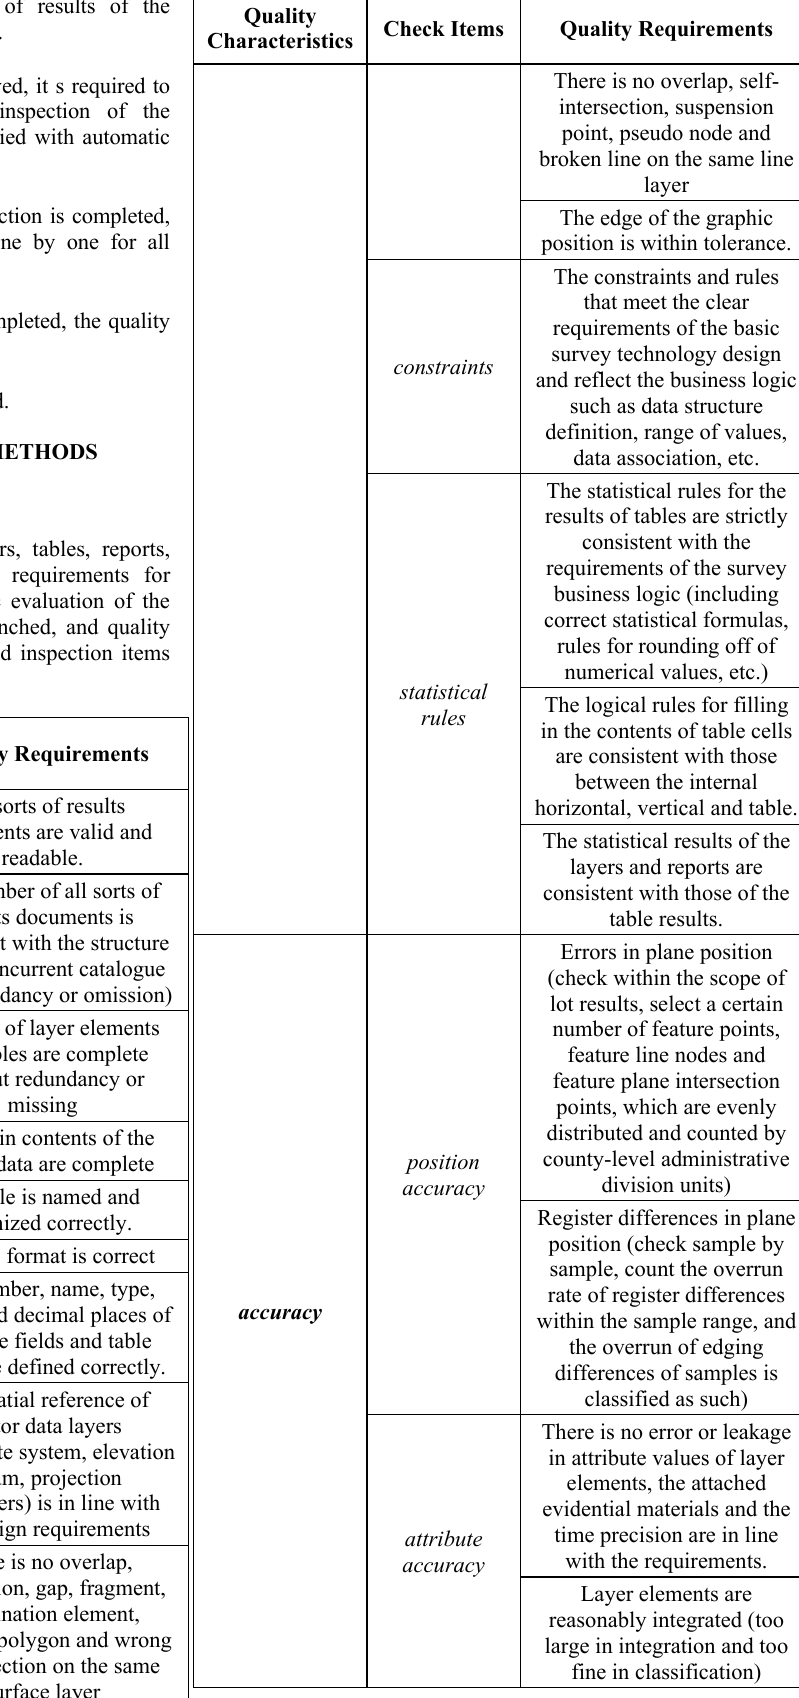
Table 1. Quality